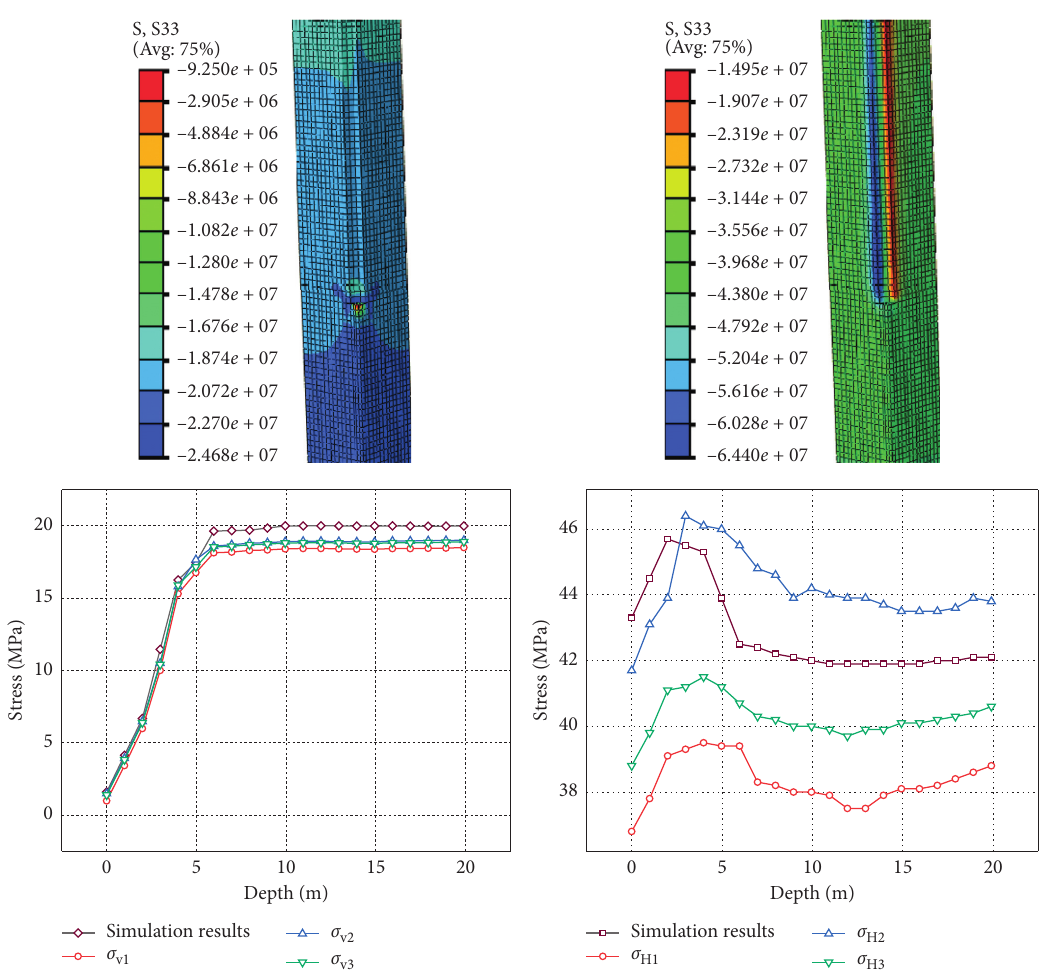
Figure 7: Stress nephogram and the in situ tress